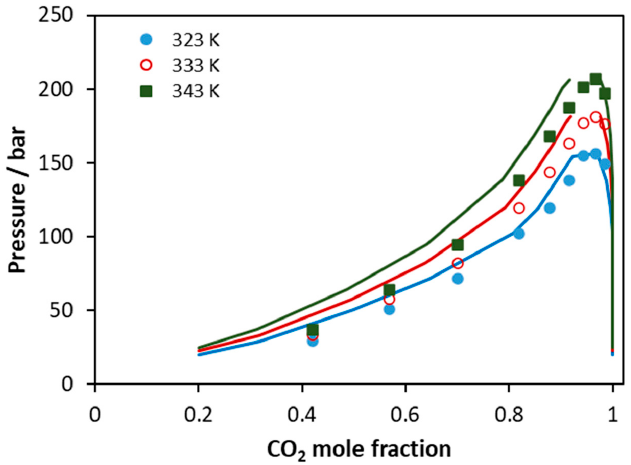
Figure 13. VLE of CO 2 –biodiesel system. Experimental data (points, [58]) and CPA predictions (lines) using the binary interaction parameters of Table 6.